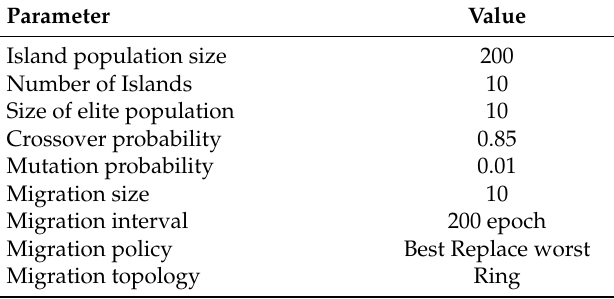
Table 3. Parameters of the genetic